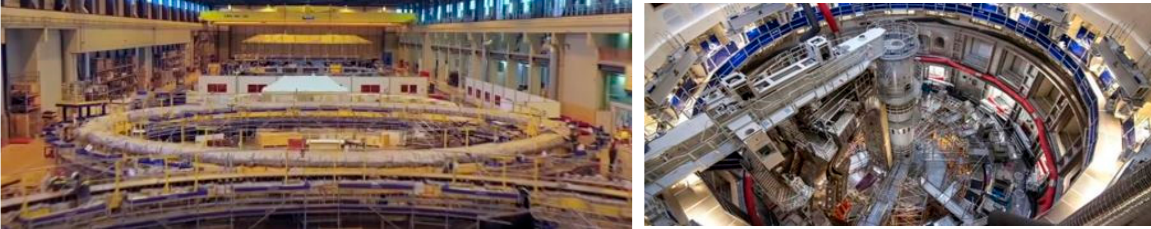
Figure 32. ITER nuclear fusion reactor ( left ) and comparable Chinese system ( right ) [70].